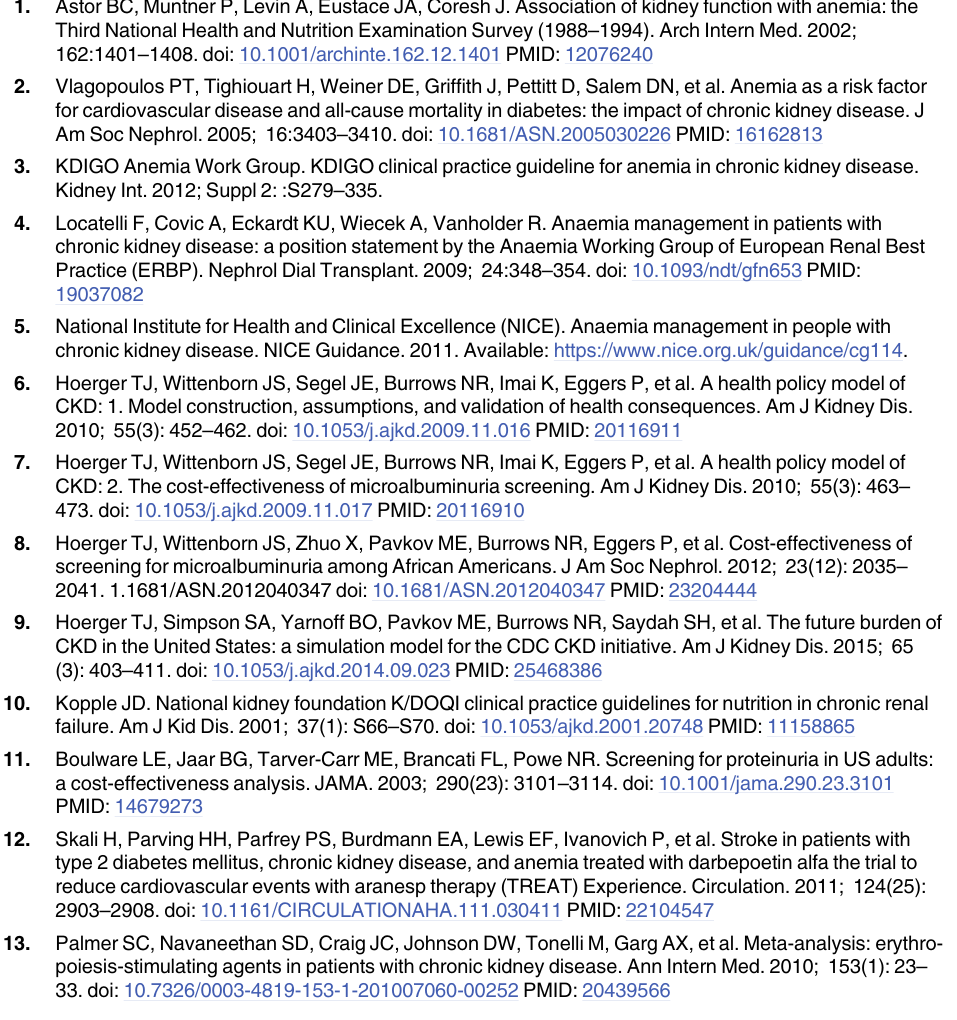
S1 Fig. Distribution of incremental costs and QALYs in probabilistic sensitivity analysis by treatment target. (A) Hb target = 10 g/dl; (B) Hb target = 10.5 g/dl; (C) Hb target = 11 g/dl; (D) Hb target = 11.5 g/dl; (E) Hb target = 12 g/dl; (F) Hb target = 12.5 g/dl; (G) Hb target =